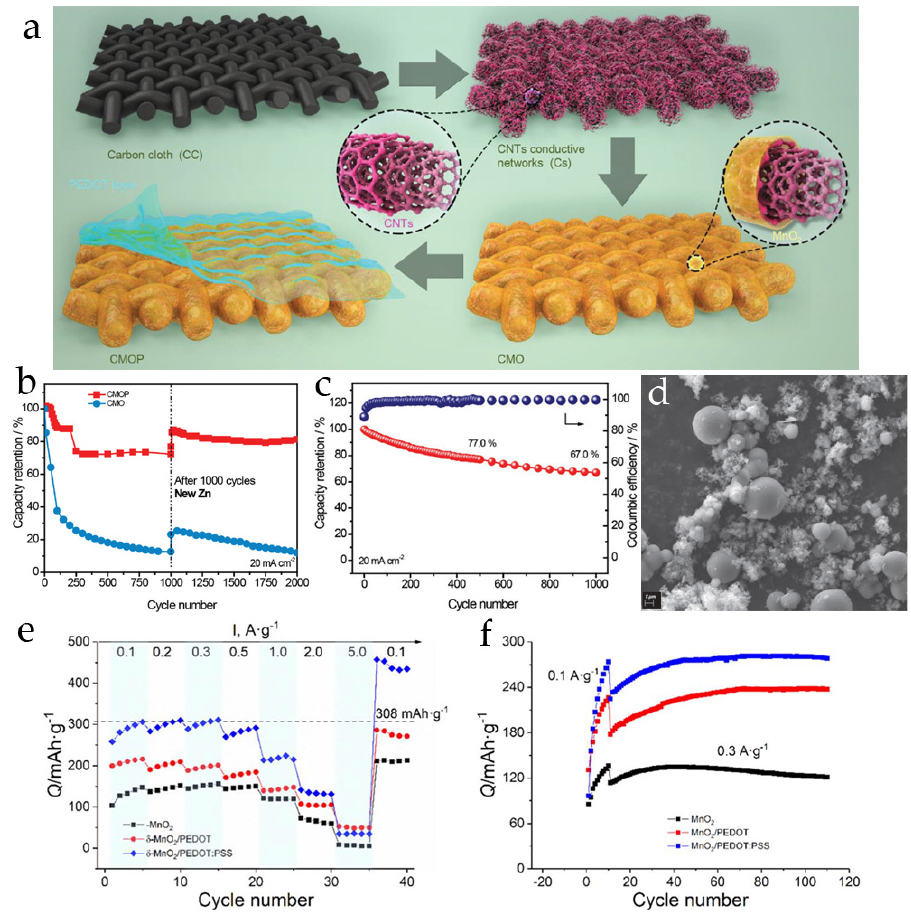
Figure 11. ( a ) Scheme of the CMOP composite cathode synthesis [91]. ( b ) Cycling stability of CMO and CMOP cathodes (Zn anodes were replaced by fresh ones at the 1001st cycle) [91]. ( c ) Cycling performance and Coulombic efficiency of the quasi-solid-state Zn–CMOP battery [91]. ( d ) SEM of PEDOT powder [97]. ( e ) C-rate capabilities of δ -MnO 2 -based electrodes. ( f ) Cycling stability of δ -MnO 2 -based electrodes at 0.3 A·g − 1 [97].